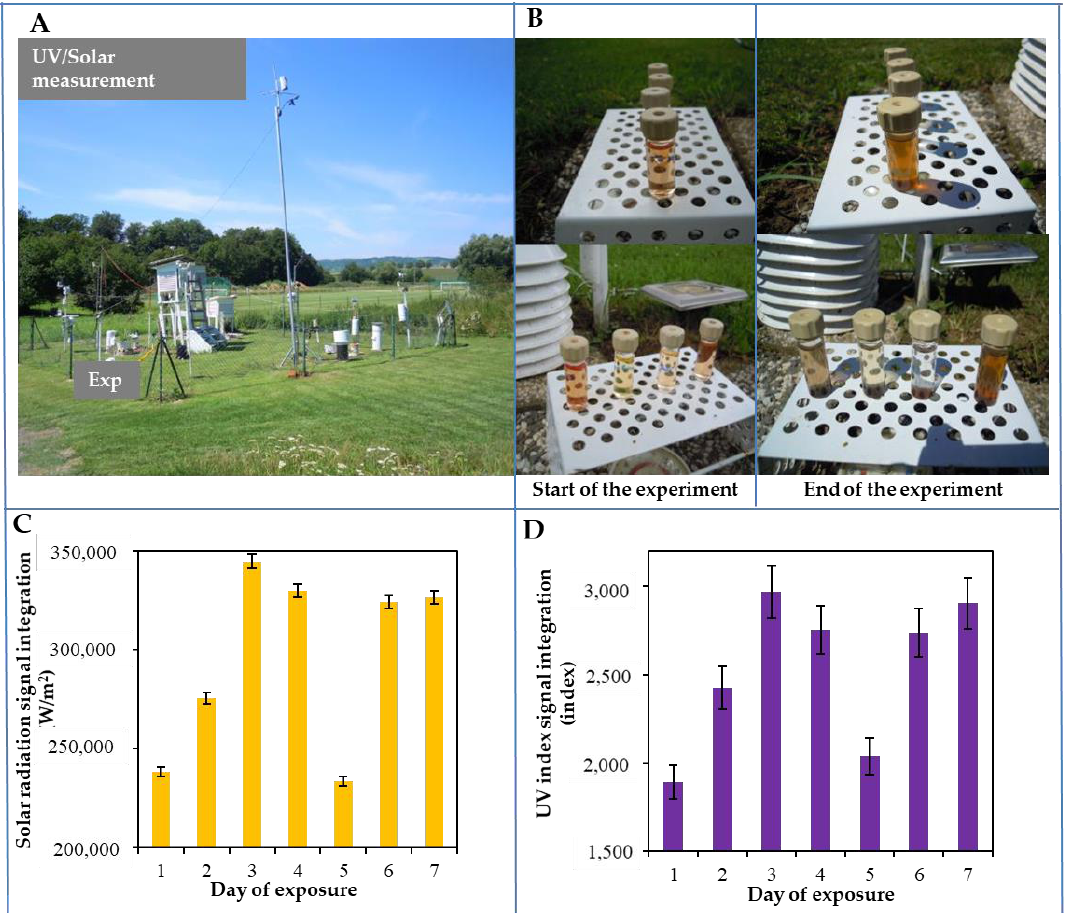
Figure 2. Performance of a field environmental experiment at the Boritov Biophysical Station. ( A ) The station is located in the Boskovice Trench near Maly and Velky Chlum at an altitude of 490 m a. s. l. The experiment was carried out on a plot of land with a regularly mowed common lawn ( Festuca, Lolium, Achillea, Taxaracum ). At the experiment site, the available physical data were obtained by using the Davis technique with one-minute intervals. Each test quartz vial with CdTe QDs was placed on a white platform so that nothing was shielded. A close-up of the experiment (both the beginning and the end of the experiment) is shown in part ( B ) The above figure shows the integral sum of the areas measured by both solar irradiance (W / m 2 ) ( C ) and the UV index values ( D ) Further experimental details are described in the Materials and Methods section.